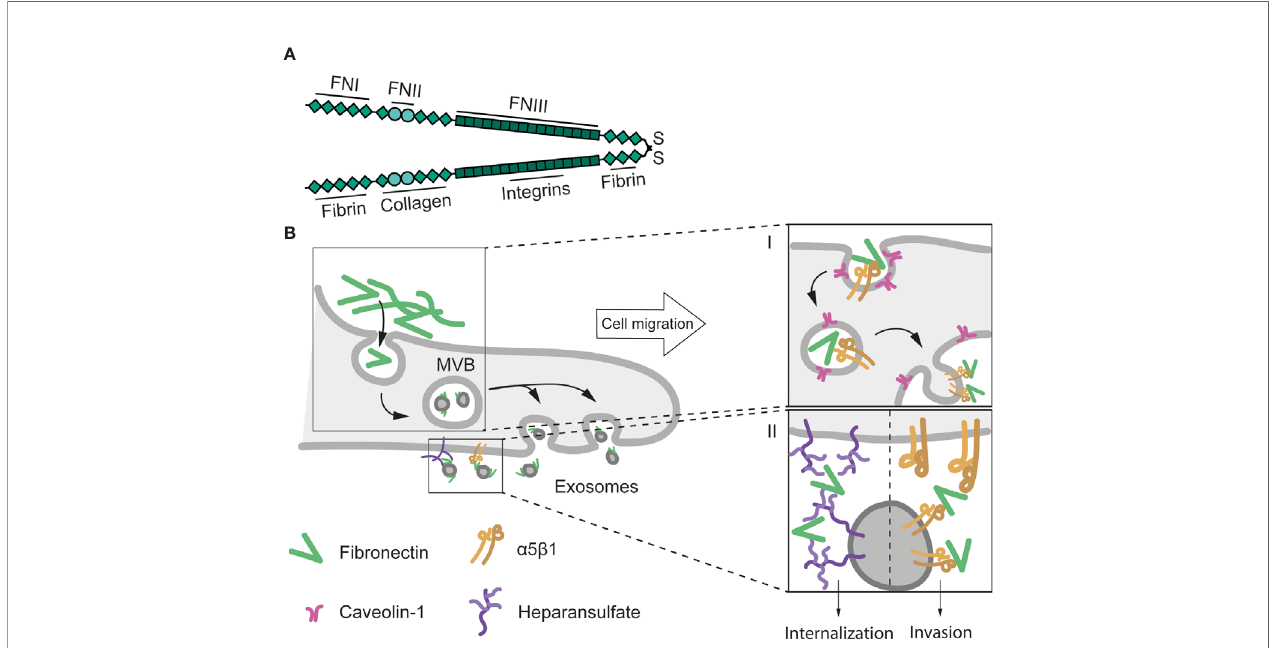
FIGURE 3 | Structure and exosomal secretion of FN. (A) Structure of a FN dimer stabilised by a di-sulphide bond. Basic domains (FNI, II, and II) and the main binding sites to other ECM proteins and receptors are depicted. (B) Exosome-mediated FN secretion and cell migration. Caveolin-1-dependent b 1 integrin endocytosis is implicated in the internalization of extracellular FN. Upon endocytosis, FN is transported to endosomes, where exosomes are formed (stage I) (189). Exosomal FN is then released at invadopodia, and induces cell migration and invasion through its internalization (138) or via activation of integrin-mediated pathways (192) (stage